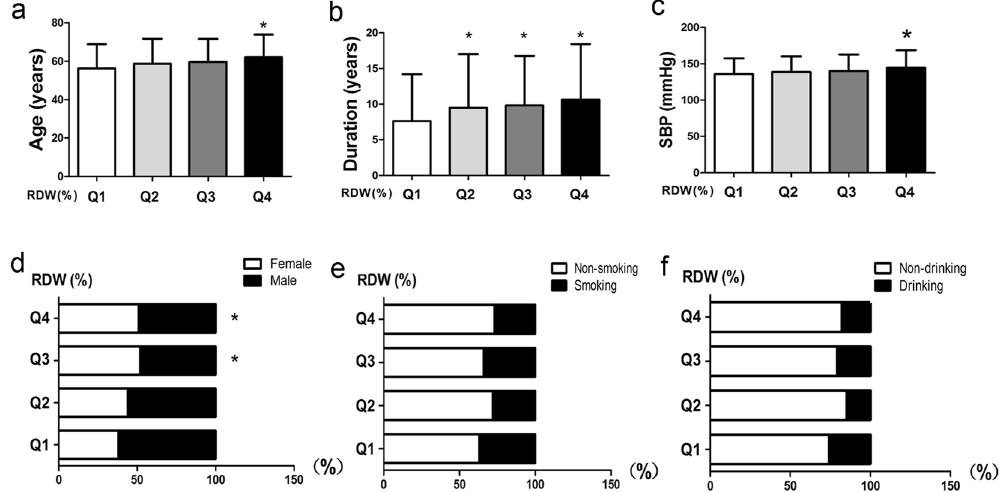
General characteristics of Q1 to Q4 in type 2 diabetic patients. As shown in Table 1 and in Fig. 1a–f, group Q4 showed the higher average age (62.10 ± 11.88 years) compared to Q1 group (56.33 ± 12.59 years), Fig. 1a. The male ratio was lower in the Q3 group (48.2%) compared to that of the Q1 group (62.0%), Fig. 1d. Moreover, compared to the Q1 group (7.63 ± 6.58), T2D patients of Q4, Q3 and Q2 group showed all the longer average duration years (10.65 ± 7.77, 10.24 ± 6.80, 10.03 ± 7.37), Fig. 1b, and higher average SBP (144.56 ± 24.18), Fig. 1c, and the proportion of smokers and drinkers (Fig. 1e, Fig. 1f). There were no significant differences in the distributions of DBP, BMI among the Q1 to Q4 groups. Laboratory results of blood and urine in type 2 diabetic patients. Compared to the Q1 group, in the Q4 group, the T-test or the non-parametric Kruskal-Wallis test showed that Hb (g/dL), Alb (g/L) and HbA1c (%) levels were significantly lower, but BUN (mmol/L), serum Ca 2 + (mmol/L), Cr ( μ mmol/L), UA (mmol/L), Upro (mg/L) and HbA1c (%) levels were significantly higher (Table 2 and Fig. 2a–h) (P < 0.01). For the distributions of WCC ( * 10 9 ), MPV (fl), PCT (%), P-LCR (%), PDW(%), TG (mmol/L), TC (mmol/L), HDL (mmol/L), LDL (mmol/L), serum phosphorus (mmol/L), and FBG (mmol/L), no significant differences were observed among the four groups. Complications and medications of the Q1 to Q4 groups in type 2 diabetic patients. Compared to the Q1 group, the patients in the higher Q3 or Q4 groups had increasing morbidities of DR, HTN and using CCB. The Q3 group had a higher rate of DPN compared to the Q1 group (61.9% vs 46.7%, P < 0.05). Moreover, groups Q2 and Q4 had more morbidities of CHD compared to the Q1 group ( P < 0.05), and Q4 group used less OHA than Q1 group ( P < 0.05). (Table 3 and Fig. 3a–f). No significant differences were found in either category of patient treatment, with or without ACE-I or ARB, β -Blocker, lipid-lowering agents, or insulin ( P > 0.05).